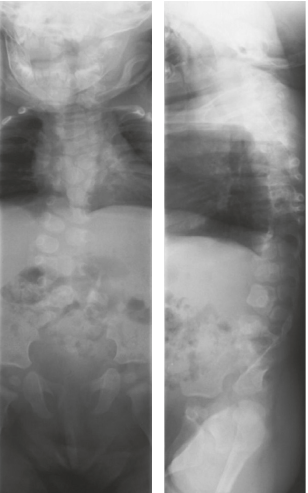
Figure 1: Anteroposterior (AP) and lateral radiographs obtained at 6 months of age demonstrating multiple, asymmetric vertebral segmentation defects of the thoracolumbar vertebra accompanied by asymmetric rib deformities, partial distal sacral agenesis, and fused cervical